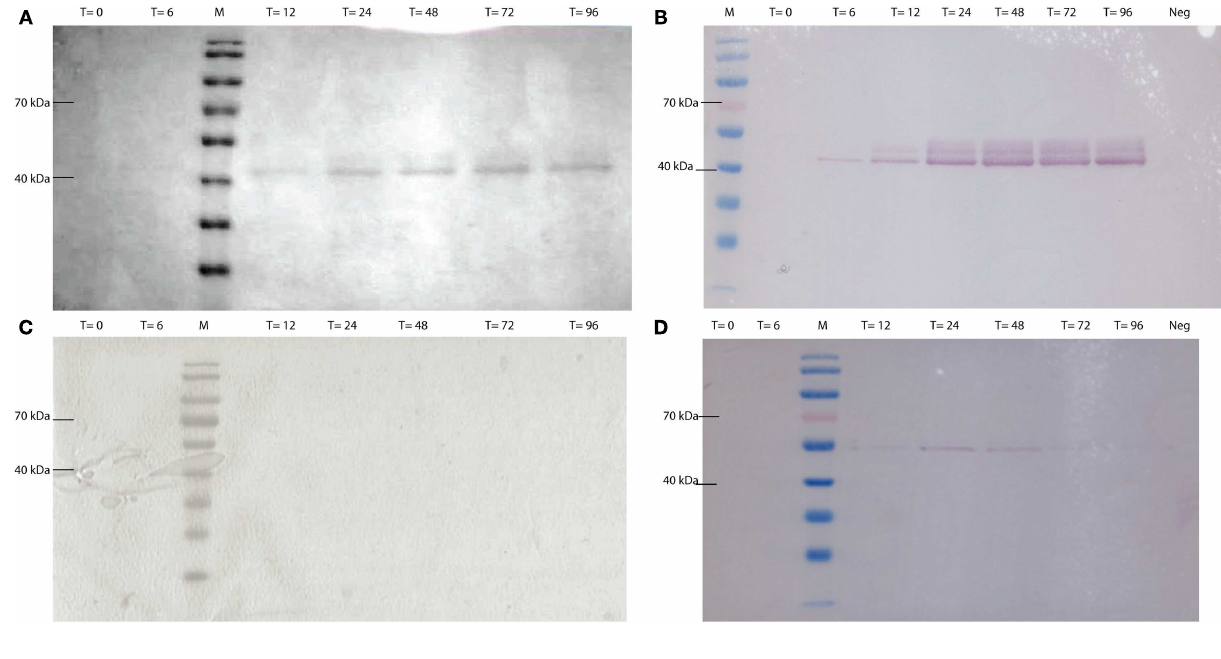
Production of CEL-HYB1 (B) and CEL-HYB1-CBM (D) was confirmed by Western blot with the c-myc antibody. Culture supernatant was harvested at the specified times ( T = 0, 6, 12, 24, 48, 72, and 96h; Neg = negative control; M = PageRuler™, Fermentas) after induction with 0.5%